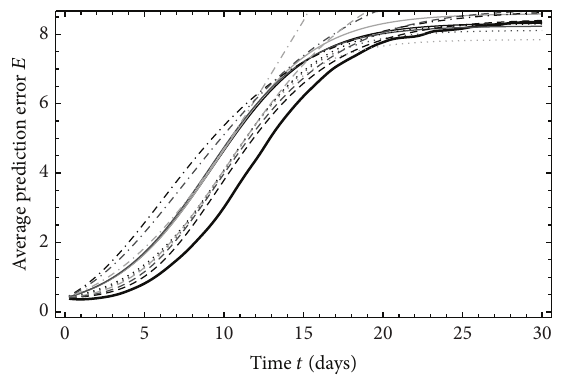
Figure 3: As Figure 2 for ND 3 , 𝑀 5 .